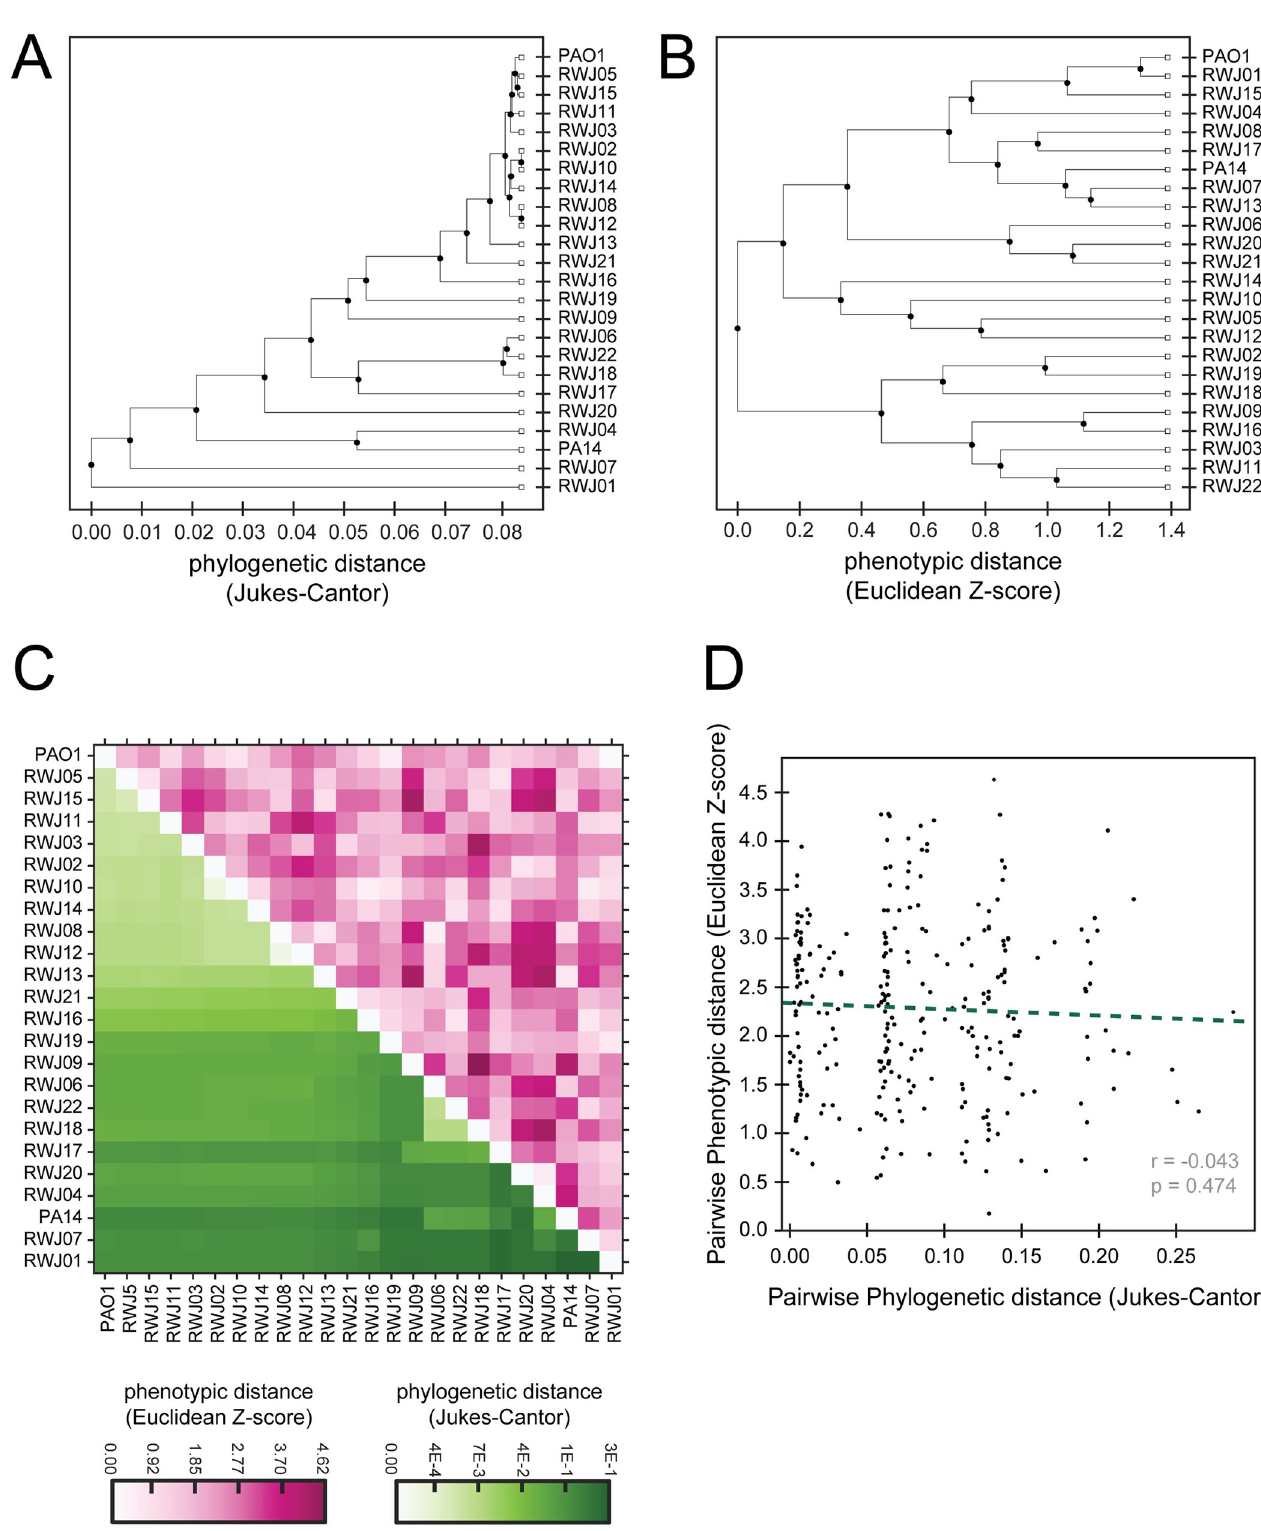
Fig 3. Clustering of phylogenetic data and phenotypic data are not correlated. (A) Phylogenetic tree of the RWJ samples, PA14, and PAO1 based on the genes dnaE , guaA , gyrB , mreB , mutS , ppsA , recA , rpoB , and rpoD . (B) Phenotypic clustering based on the 3 virulence assays tested. (C) The clustering order from the phylogenetic tree used to reorder the phenotypic data. White to dark green color used to display phylogenetic distance. White to dark pink color used